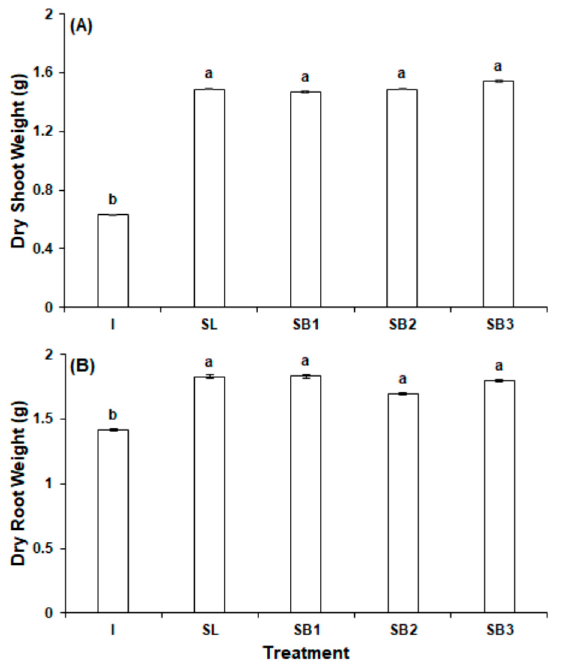
Figure 2. Dry weight of radish in experiment 1: ( A ) shoot weight ( B ) root weight. All different letters are significant at p <